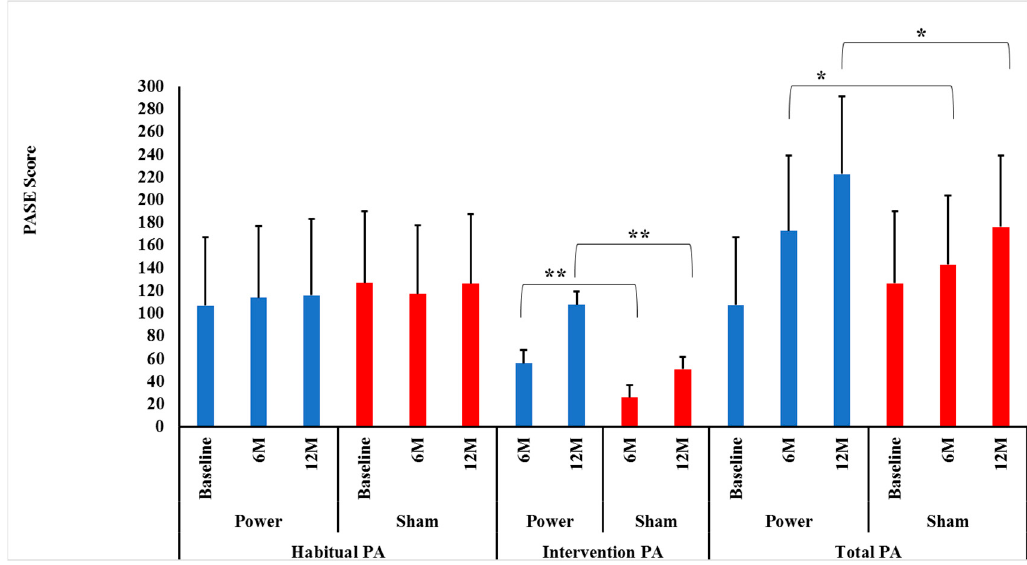
Figure 2. Intervention, habitual and total physical activity level between groups by time. Data presented as mean ± SD. M = months, Power = power training group (BLUE bars), SHAM = control group (RED bars). There were no significant Group×Time interactions for habitual physical activity (PA) between power and SHAM groups over 0–6 or over 0–6–12 months ( p = 0.16 and p = 0.51, respectively). ** There were significant Group × Time interactions for intervention PA between power and SHAM groups over both 0–6 and over 0–6–12 months ( p = 0.0001 and p = 0.0001, respectively). Bonferroni post-hoc t -tests showed power training had a higher intervention PA at both 6 ( p = 0.0001) and 12 months ( p = 0.0001) compared to SHAM. * There were significant Group × Time interactions for total PA between power and SHAM groups over 0–6 and over 0–6–12 months ( p = 0.0001 and p = 0.0001, respectively). Bonferroni post-hoc t -tests showed power training had a higher intervention PA at both months ( p = 0.02) and 12 months ( p = 0.0001) compared to SHAM.